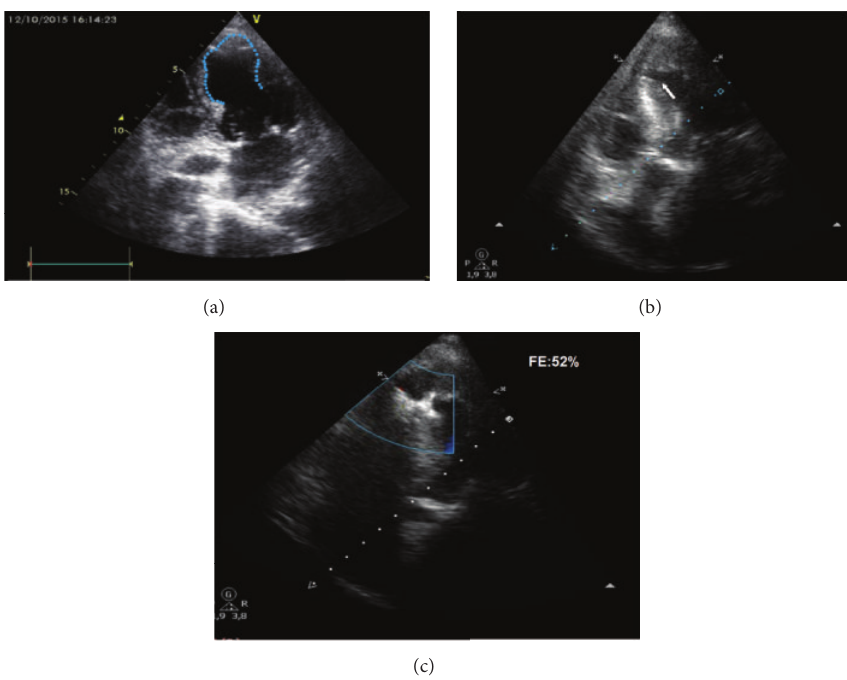
Figure 1: (a) Transthoracic echocardiogram (TTE) on admission, anterior and apical severe hypokinesia in both ventricles (apical ballooning pattern), and integrity of ventricular septum (dotted line and video); (b) TTE at the 4th day showing apical ventricular septal perforation (arrow) and a left ventricular ejection fraction of 41% (video); (c) TTE previous to discharge with the Amplatzer device and an improved left ejection fraction of 52%, with normal contractility in the right and left chambers (video).